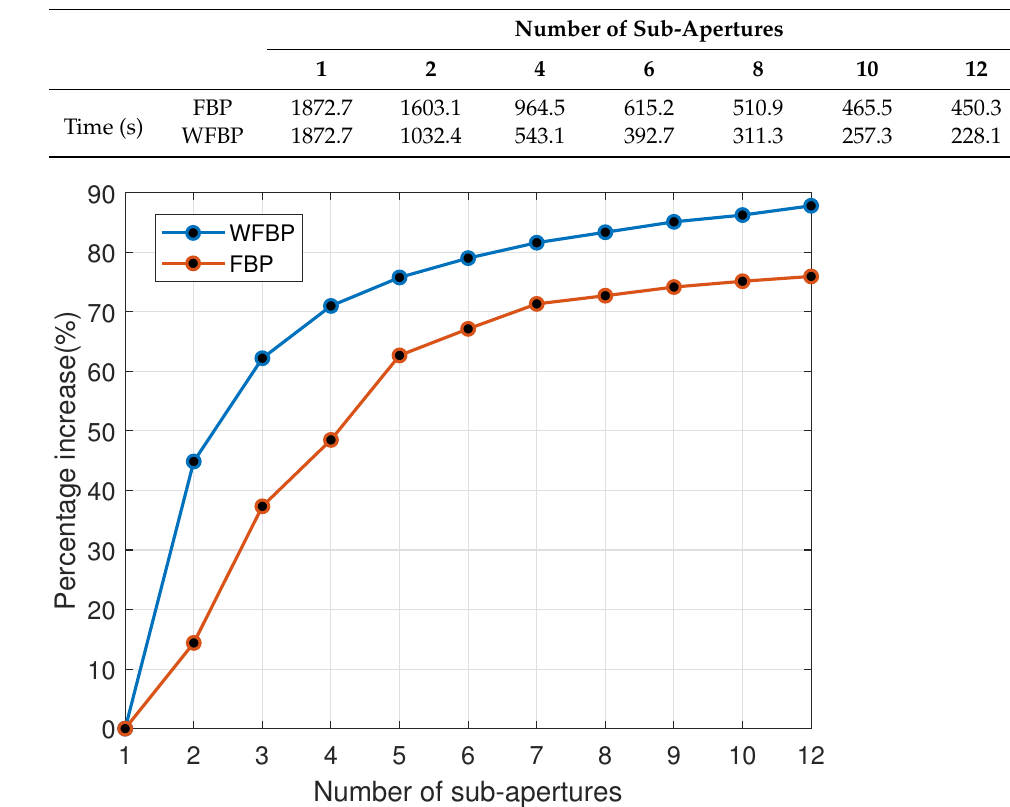
Table 5. Comparison of computation time between the WFBP and FBP algorithms.